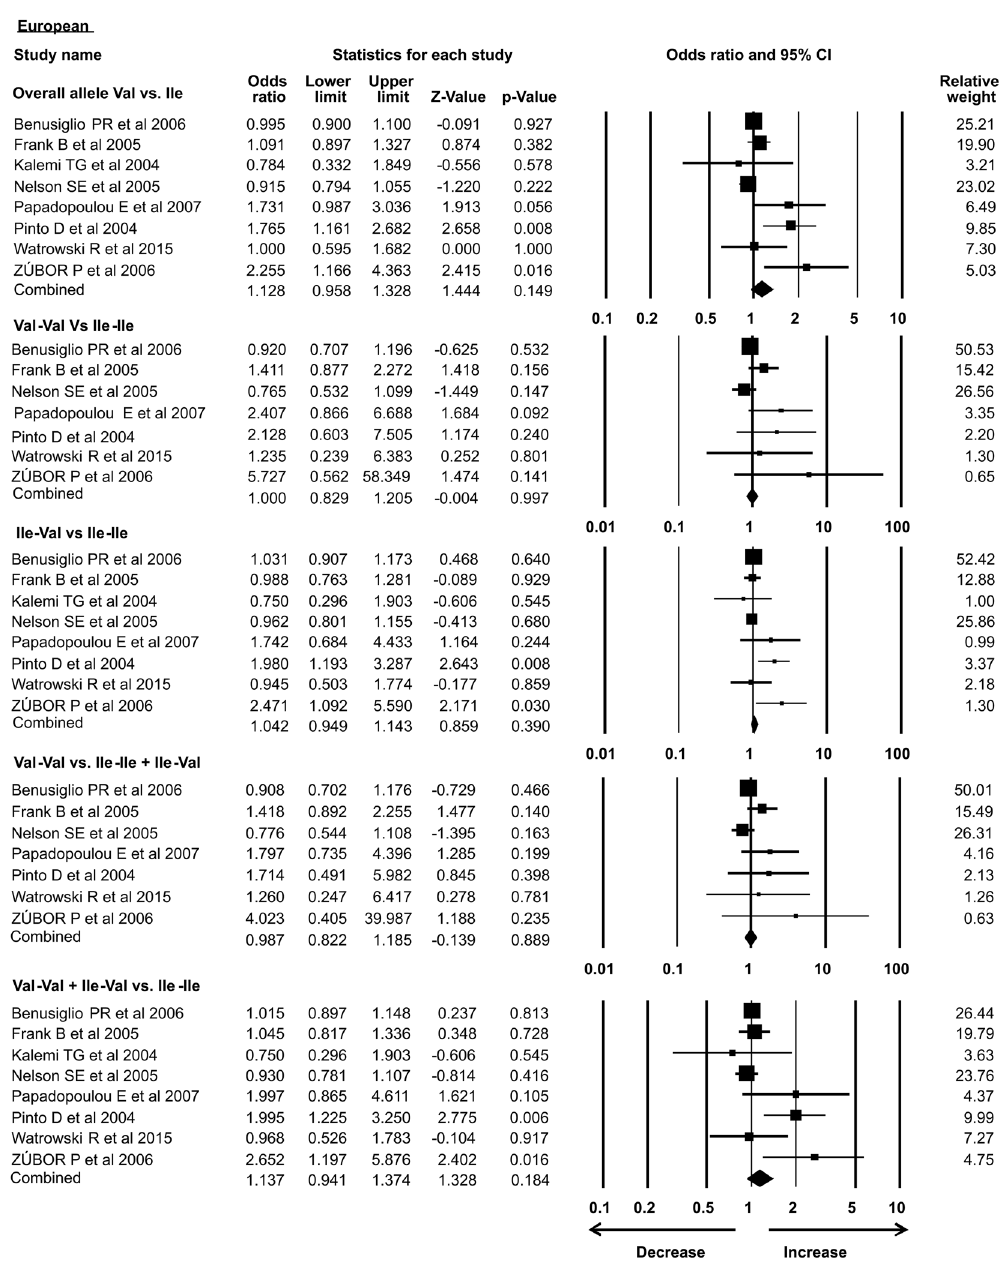
Figure 11. Forest plot: Overall analysis of Her2 Ile 655 Val (rs1136201) gene polymorphism from European subgroup with OR and 95% CI for investigating the association with breast cancer risk. Black squares represent the value of OR and horizontal line indicates 95% Confidence Interval (CI) of odds ratio